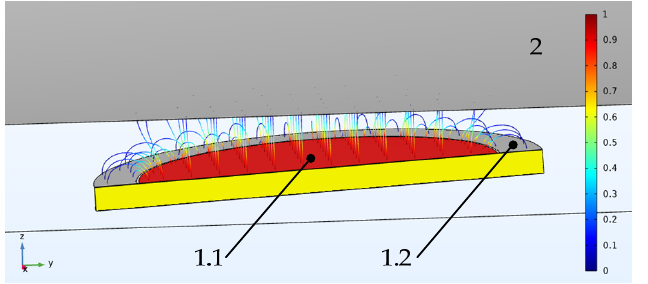
Figure 5. Rotating shaft vibration capacitive type 1 sensors with concentric electrodes: 1.1—potential electrode, 1.2—ground, 2—shaft. electrode, 1.2—ground,